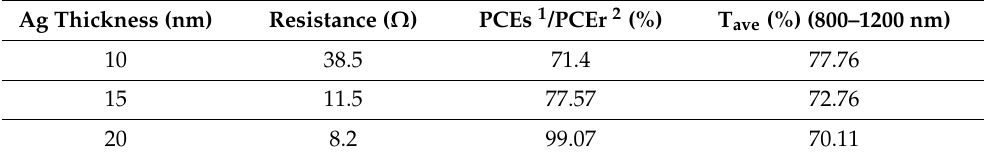
Table 4. Characteristic of PSCs using different thickness of Ag transparent electrodes. Ag Thickness (nm)